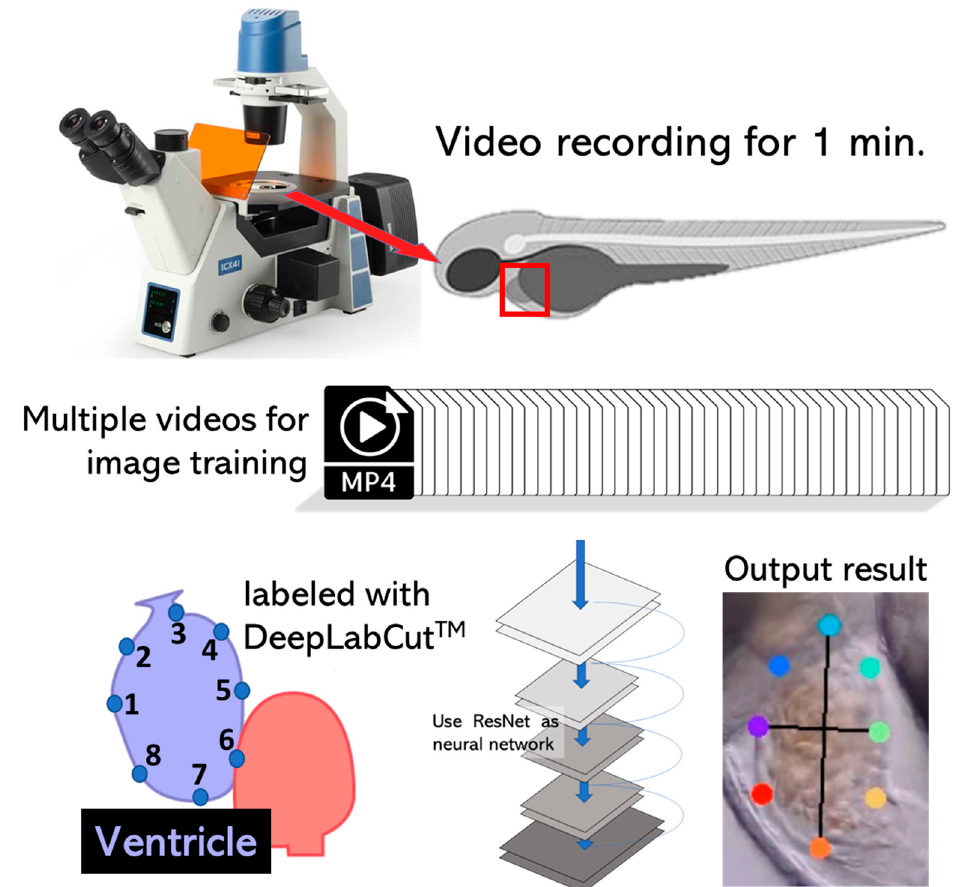
Figure 1. The experimental design was used to detect and label the heart chamber of zebrafish in this study. On top, the animal model: zebrafish ( Danio rerio ) was used in this study as it is widely used for toxicity studies since its body transparency makes it suitable for cardiovascular assessment. Up to 20 videos of a heart beating with a duration of 1 min were collected. The bottom section describes how DLC performed the training process for dataset and video analysis, resulting in a labeled zebrafish ventricle heart chamber.